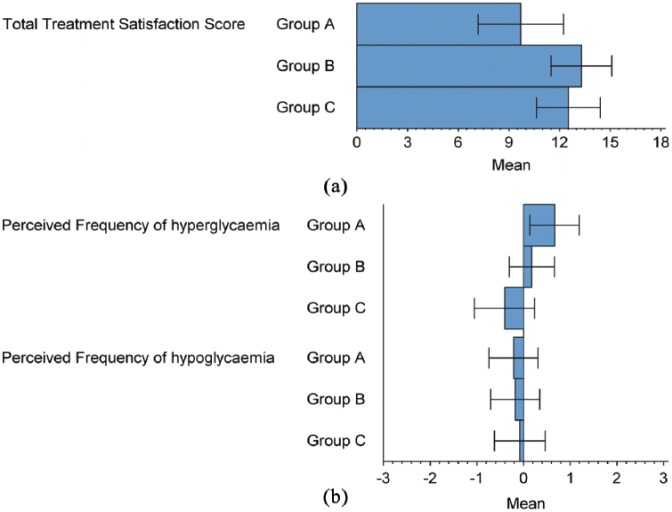
Scores from the DTSQ Questionnaire for (a) total treatment satisfaction score and (b) perceived frequency of hyperglycaemia and hypoglycaemia.